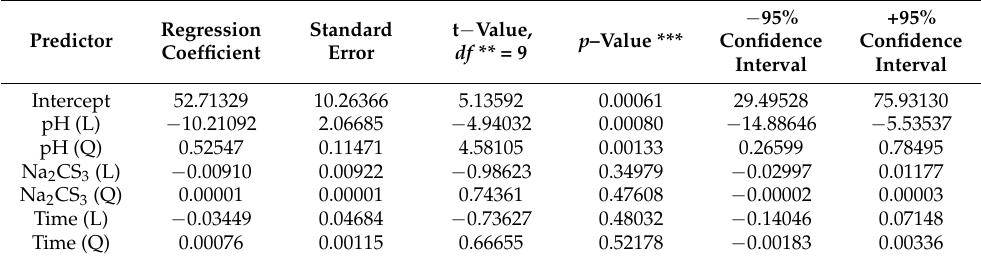
Table 6. Coefficients of the fitted model *.